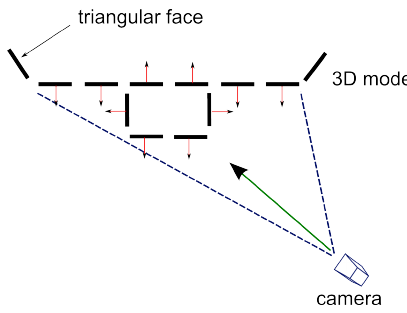
Figure 1. Texture determination. Red arrows represent the nor- mal vectors of each triangle.